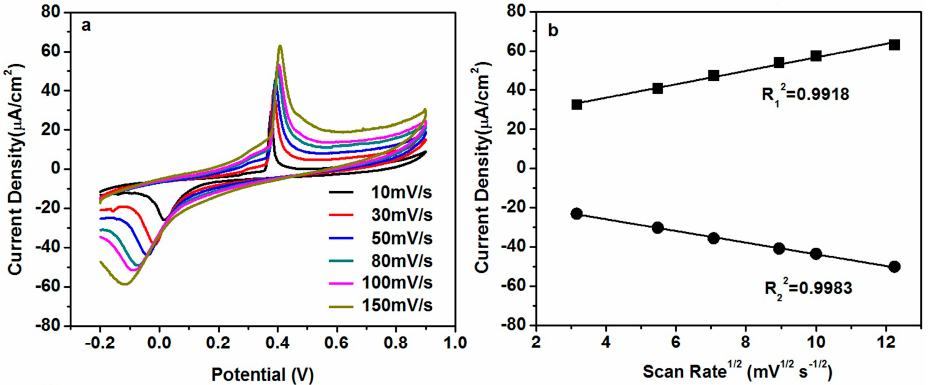
Figure 6. ( a ) CVs of CuO/CeO 2 /ITO electrode in 0.1 M PB solution containing 5 mM glucose at different scan rate; ( b ) Plot of the peak current with square root of the scan rate.